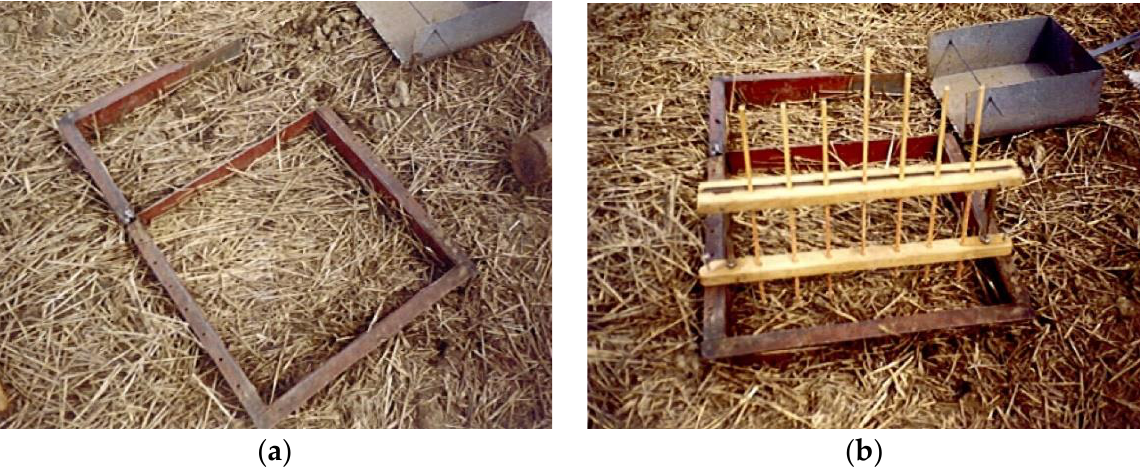
Figure 1. Steel frames, pressed to the soil ( a ); the measurement of seedbed surface roughness using a K. Trečiokas profilometer ( b ). The profilometer has seven rulers that measure the distance from the frame and seedbed surface. The measurements were performed at seven frame spots, resulting in a total of 49 seedbed surface measurements. These data were used for evaluation of seedbed sur- face and bottom roughness and sowing depth.